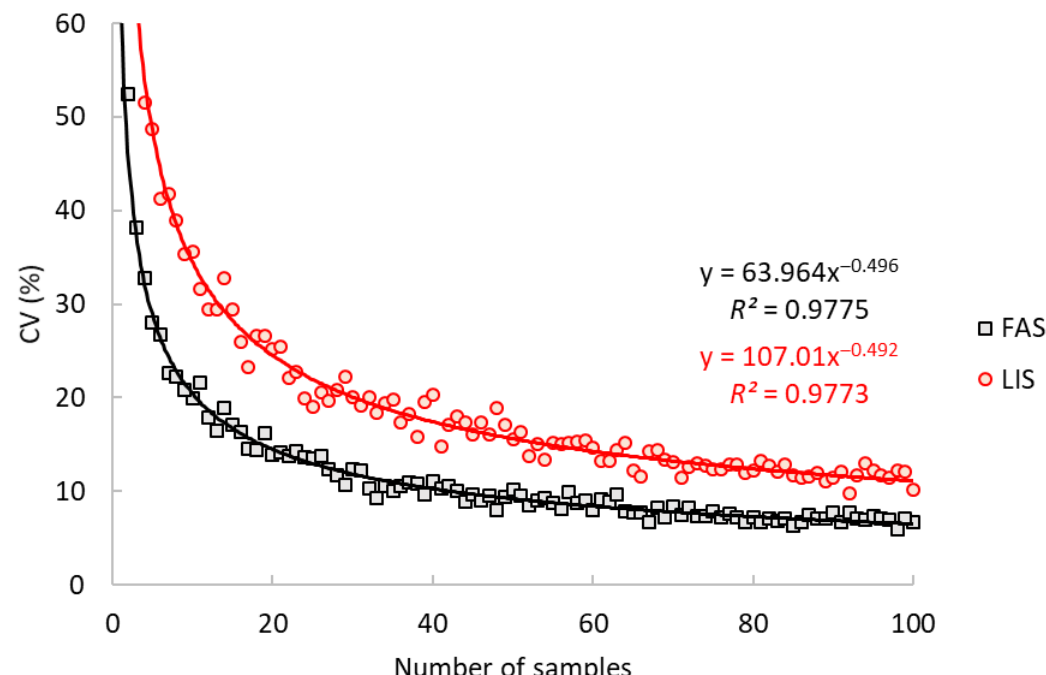
Figure 3. Sampling simulations from 1 to 100 plots for the Pilot Stand, and corresponding coefficient of variation (CV) of the estimated volume of pieces from 0 to 4 cm in diameter for the fixed-area sampling methods (FAS: black squares, quadrats of 0.46 m 2 ) and line-intersect sampling method (LIS: red circles, 0.7 m transects). Mean of 100 simulations for each number of samples (squares and circles) and the adjusted model (solid lines).